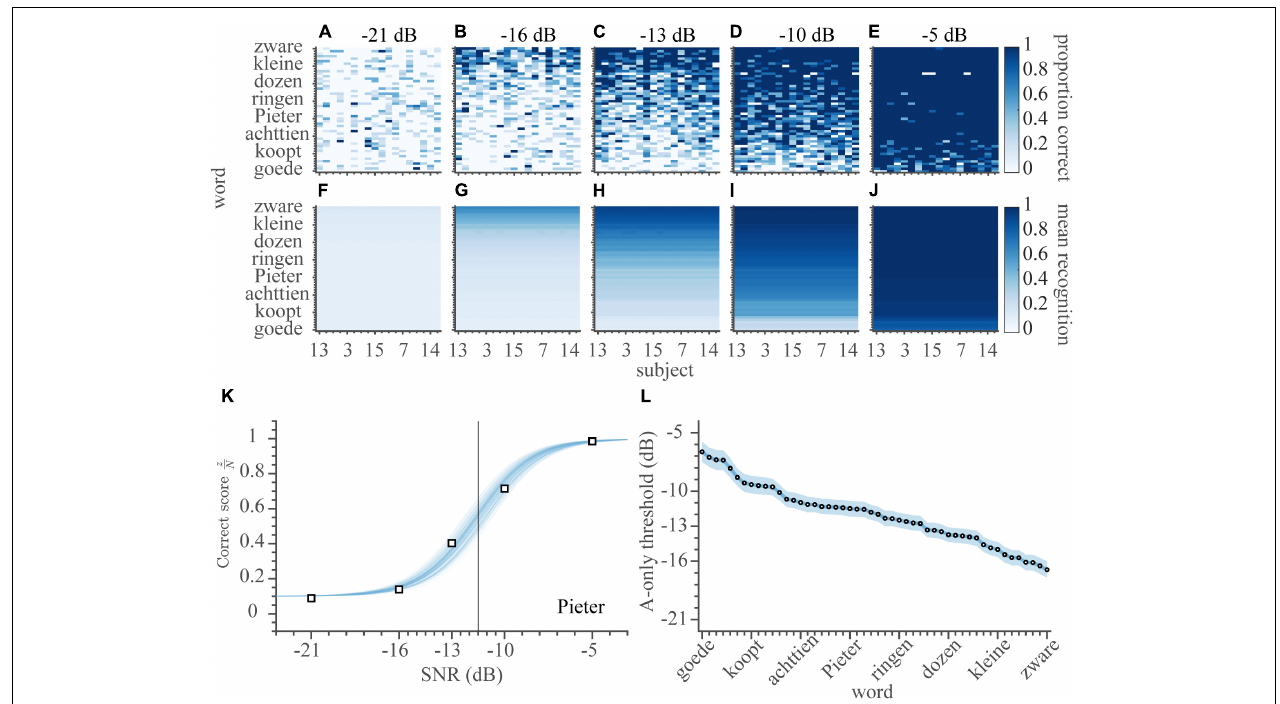
FIGURE 3 | Speech listening. Auditory word-recognition scores. (A–E) The correct score (number of correct responses divided by the number of presentations) is shown separately for every word and subject (900 entries) for each of the SNRs of − 21, − 16, − 13, − 10, and − 5 dB. The correct scores have been ordered by the average V-only rates of subjects on the abscissa, and A-only thresholds on the ordinate. (F–J) The average estimated auditory recognition rates. (K) Correct scores and psychometric fit for the word ‘Pieter’ as a function of SNR, averaged across all subjects. Open squares indicate the measured correct scores. Blue shading denotes credible fits (see Materials and Methods). Vertical bold gray line indicates the average of likely recognition thresholds. (L) A-only speech recognition thresholds, ordered from high-left to low-right. Note that a lower threshold indicates better performance. Open circles indicate means of the estimated thresholds, colored patch indicates the 95% HDI. Blueish colors denote auditory